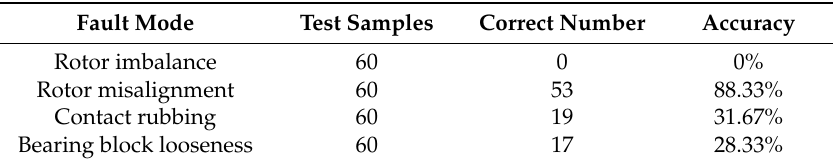
Table 4. Diagnosis results of the WGM method using the same data.